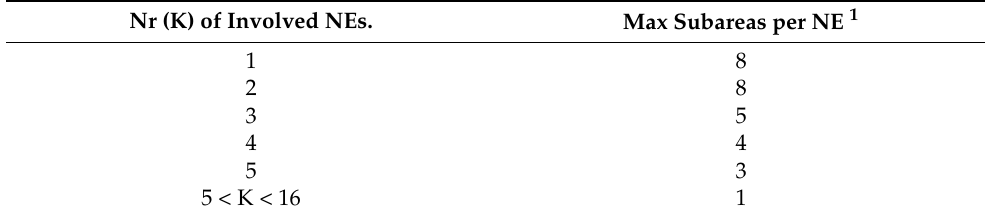
Table 6. Results of the scalability